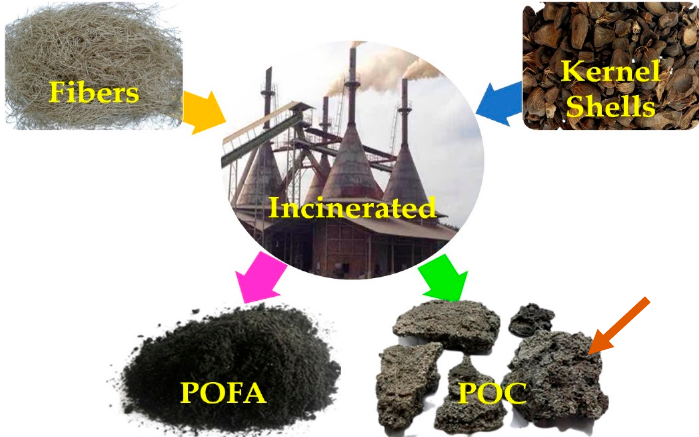
Figure 2. By-products generated from the burning of palm oil waste materials [19].